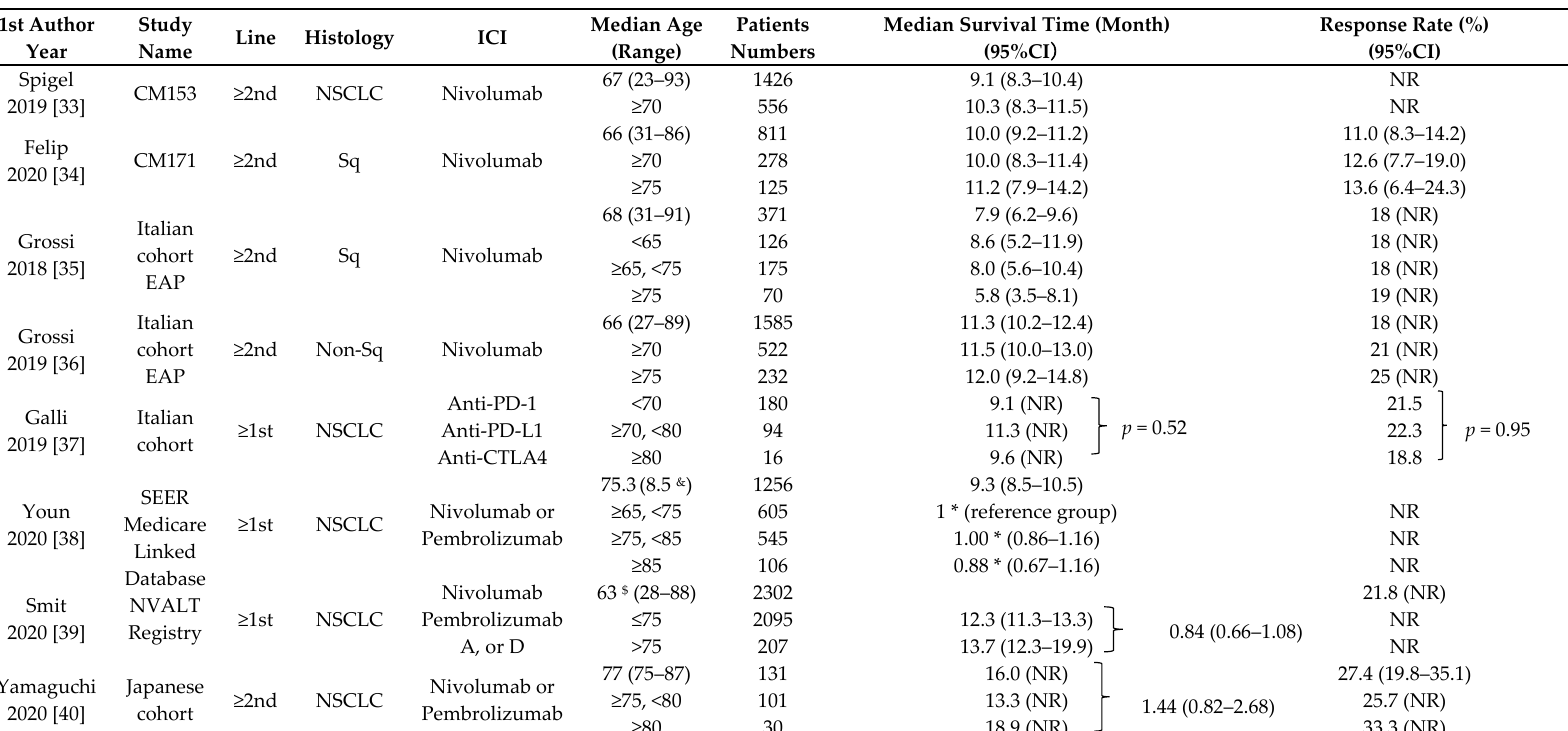
Table 2. Outcome of elderly non-small cell lung cancer patients treated with immune checkpoints inhibitors in prospective or retrospective studies.